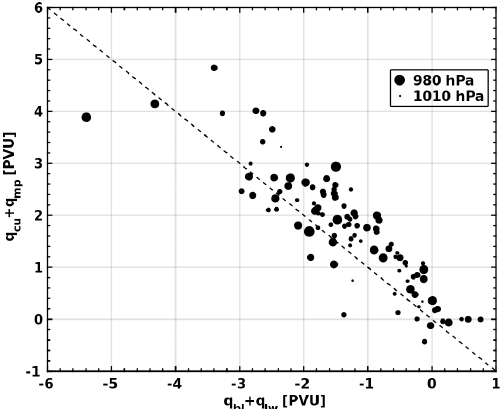
Figure 9. Scatterplot relating the sum of q bl and q lw to the sum of q cu and q mp for all 100 cyclones. Values of the PV tracers corre- spond to averages within a 100km radius around the cyclone cen- tres at the 850hPa level. The size of the dot is proportional to the mean sea level pressure at the cyclone’s centre, and the dashed line represents the q cu + q mp = − (q bl + q lw ) equation.